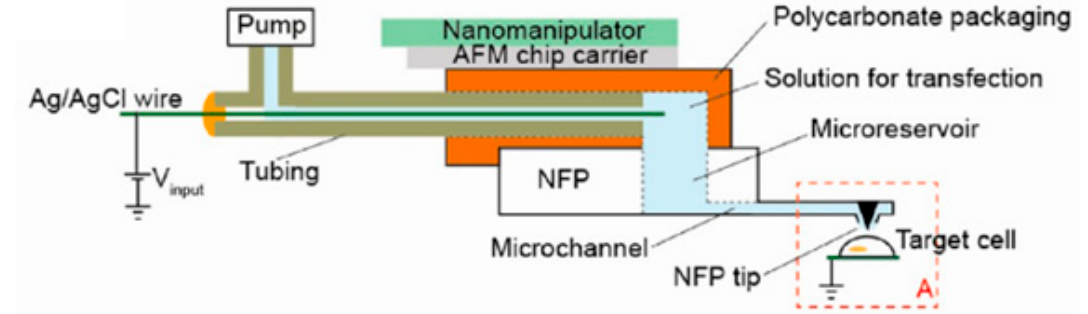
Figure 21. Schematic representation of the packed nano fountain probe (NFP) for single-cell electroporation. Reprinted with permission from [180]. Copyright (2013) American Chemical Society.